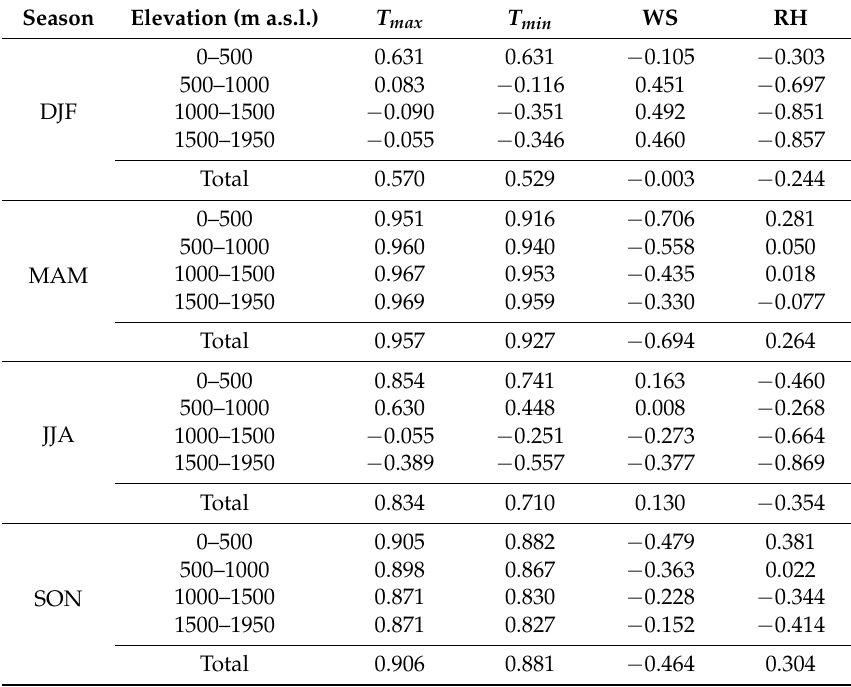
Table 3. Correlation coefficients between ET 0 and other meteorological variables ( T max , T min , WS, and RH) for different seasons and elevation ranges.